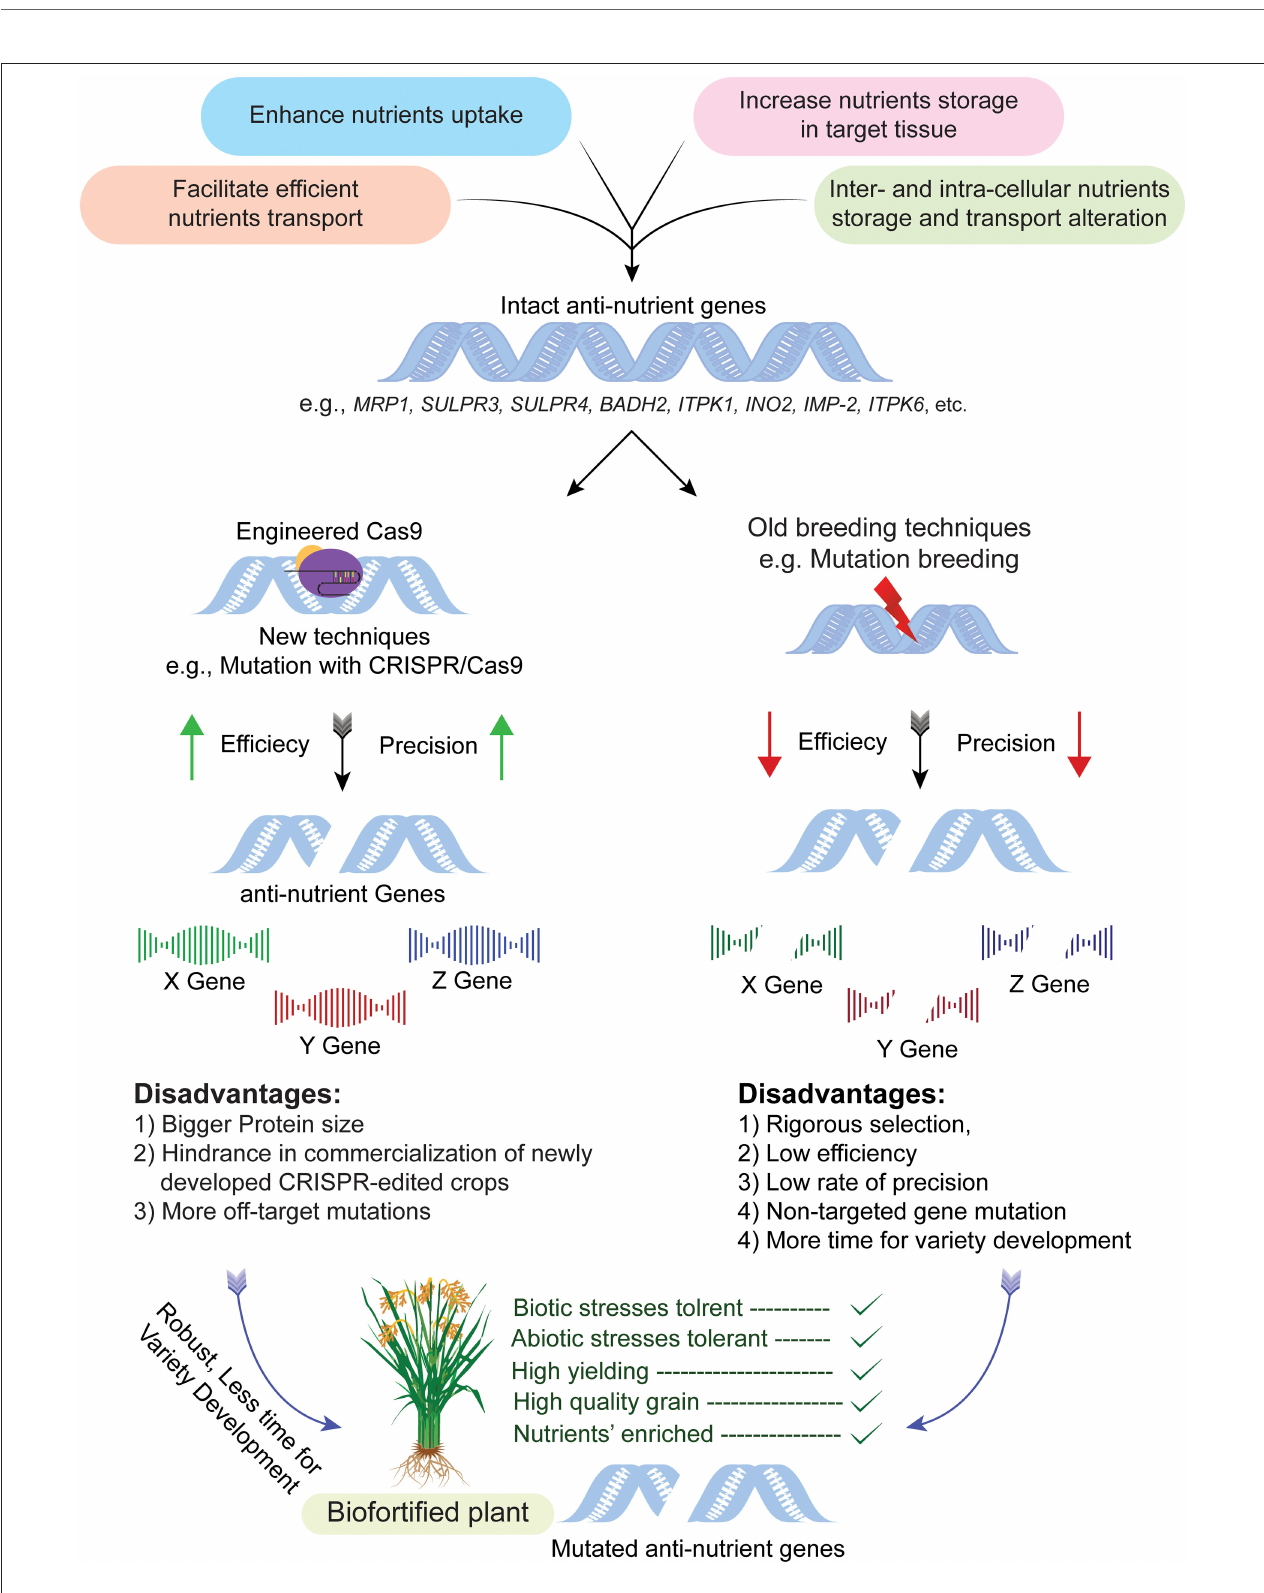
FIGURE 2 | CRISPR-Cas system mediated targeted genome editing for biofortification of crops. The process begins by selection of cultivar having anti-nutrient genes, i.e., MRP1 , BADH2 , INO2, etc., followed by CRISPR/Cas system mediated modification without disturbing the genetic makeup of the rest of the plant